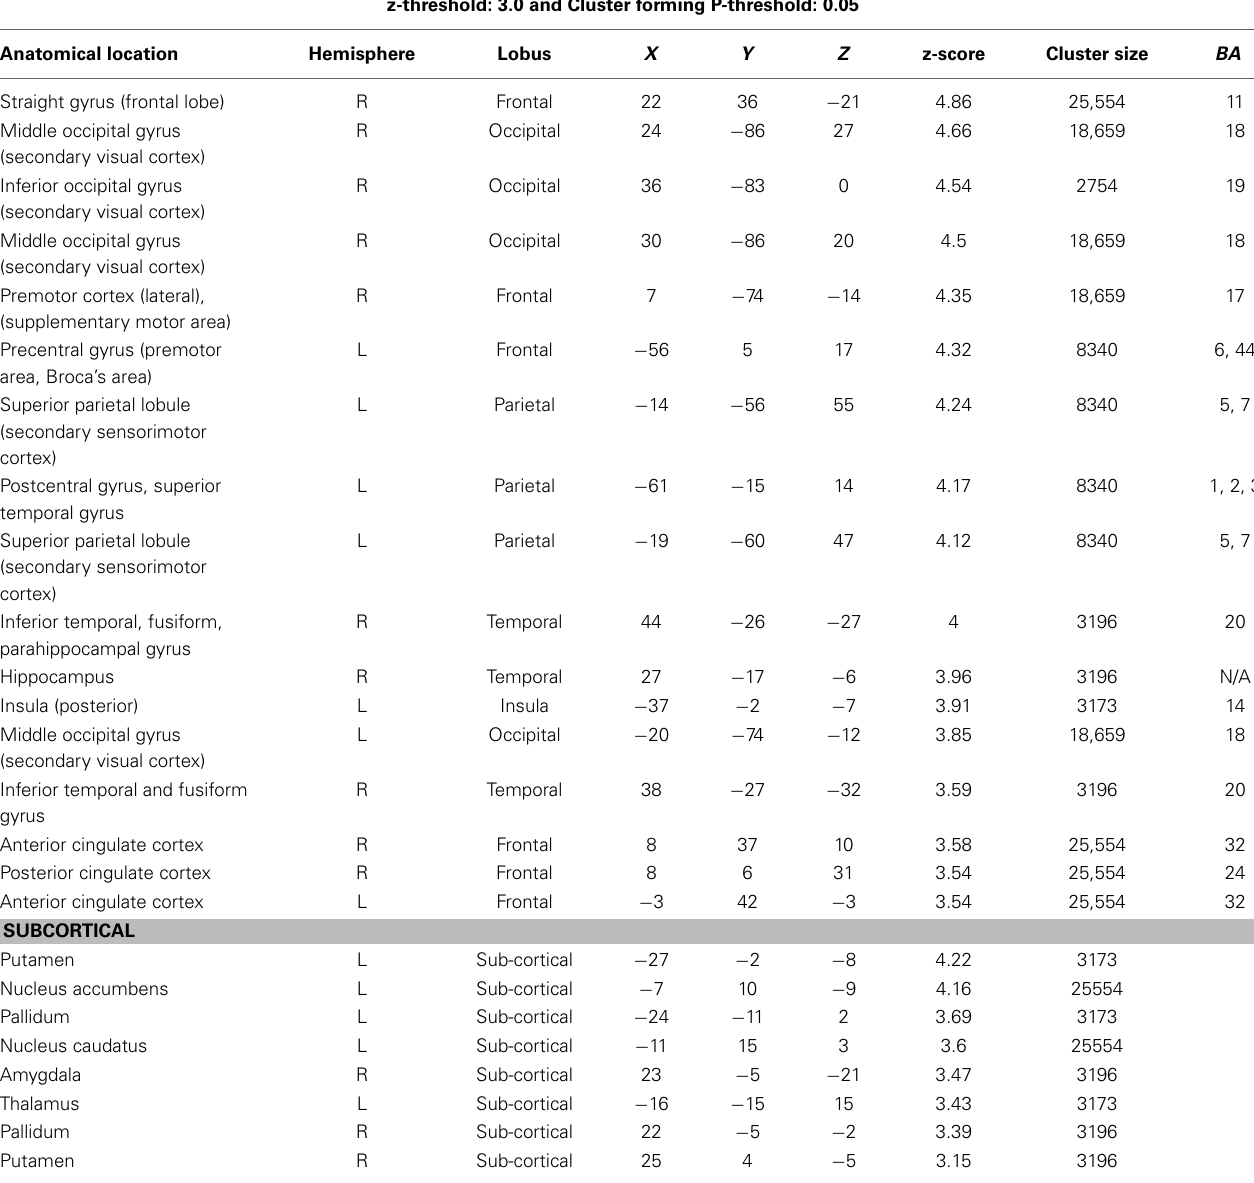
Table 2 | Cerebral regions with increased activity: nondirective meditation >